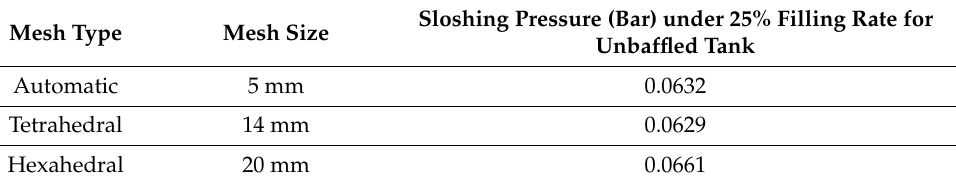
Table 3. Comparison of mesh sensitivity study.